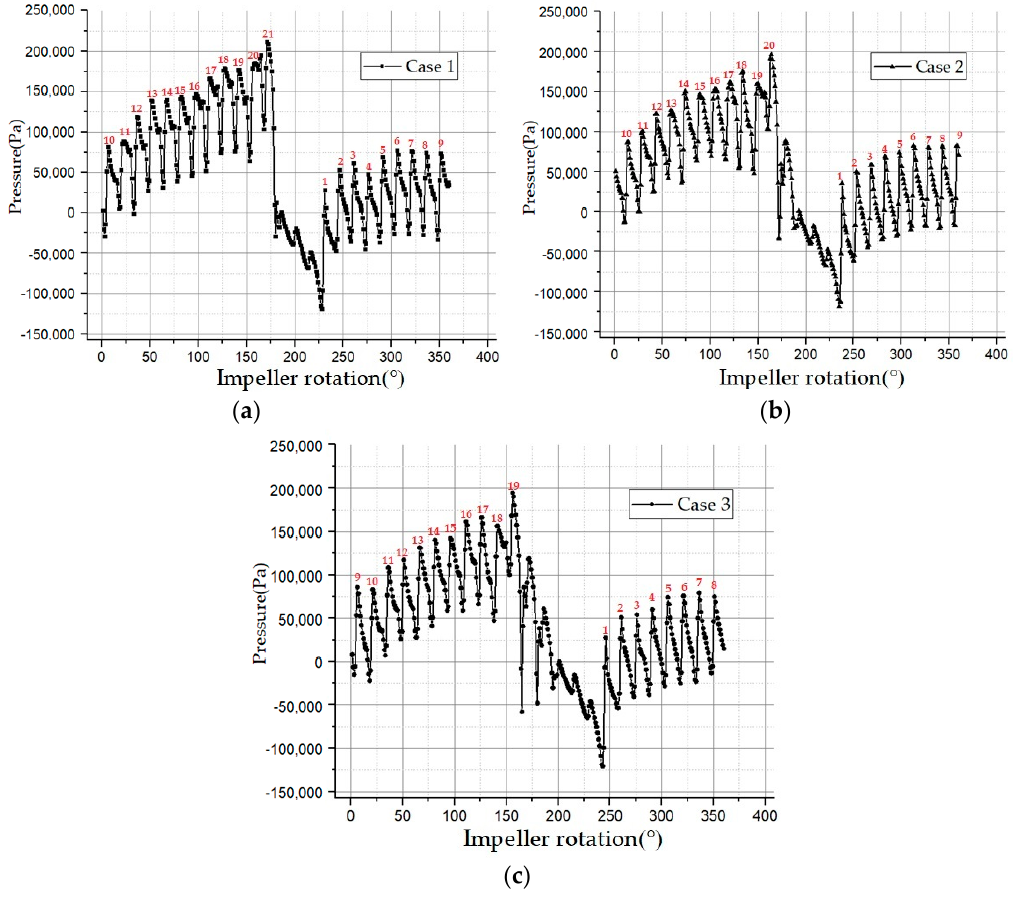
Figure 9. Static pressure distribution in the impeller. ( a ) Case 1; ( b ) Case 2; and ( c ) Case 3.